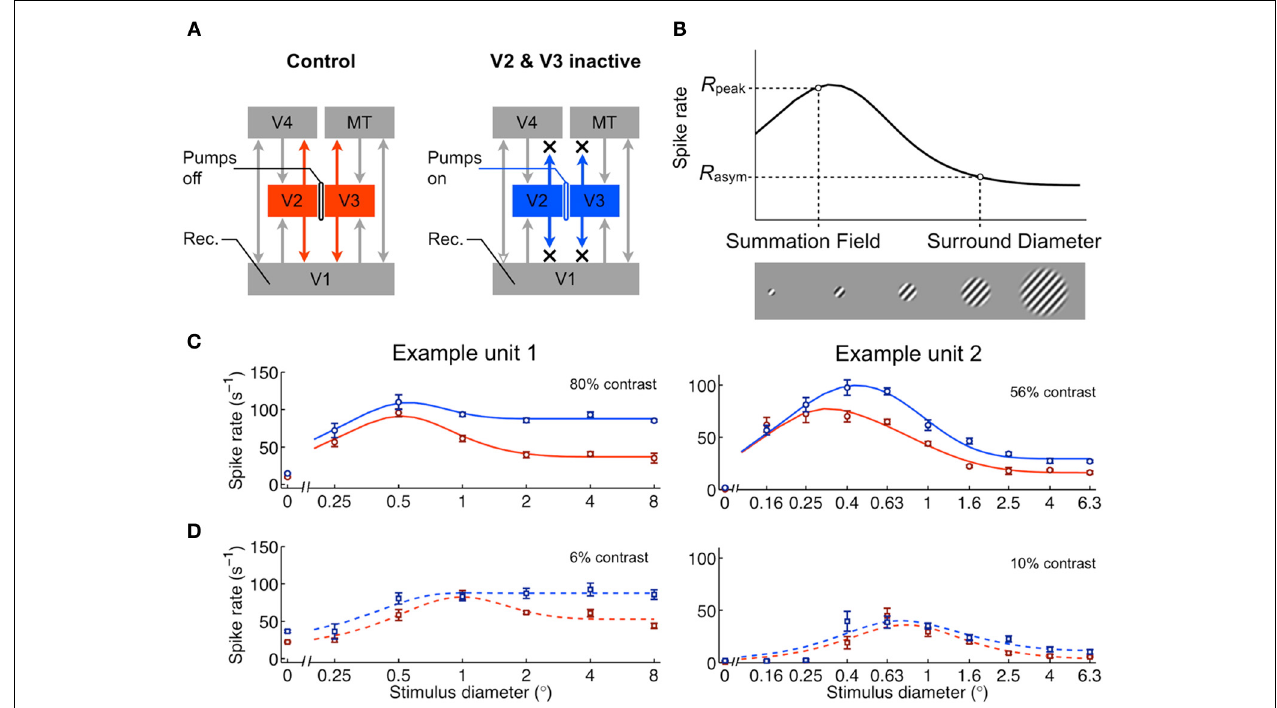
feedback inactive (blue) conditions. Data are shown as mean ± s.e.m. ( n = 5). The curves represent the fit from the model in Figure 2A . (D) Area summation curves measured from same units using low contrast gratings. The typical effect of feedback inactivation was an increase in response magnitude, particularly for high contrast gratings whose diameter extended beyond the summation field. The increased rate effect was present, yet diminished, during low contrast visual